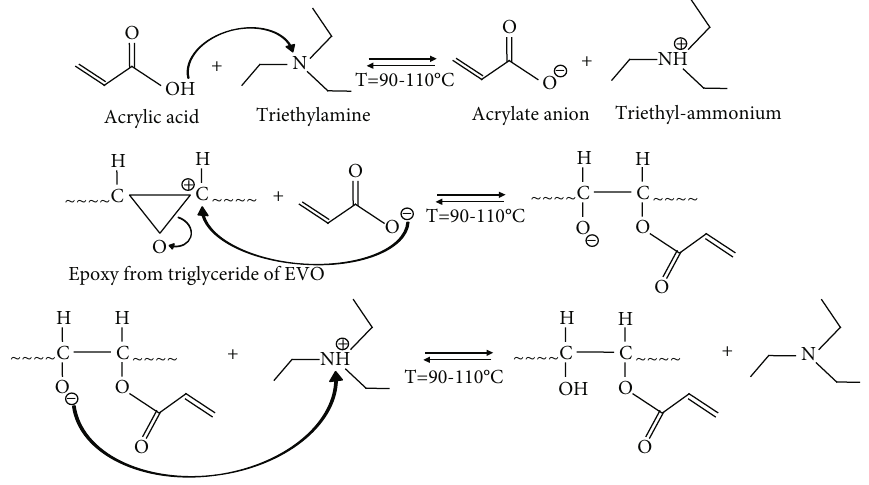
Figure 4: Reaction mechanism of acrylation process